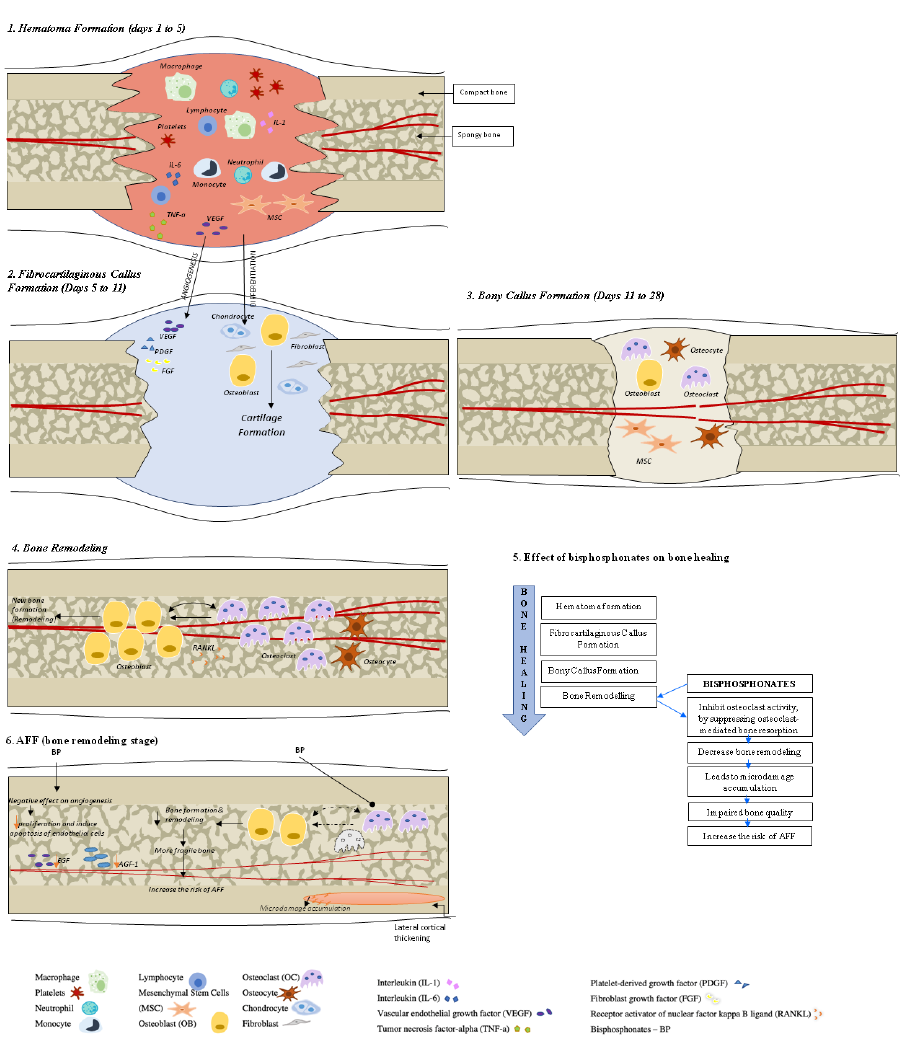
Figure 1. Bone healing in healthy bone and after atypical femoral fracture (AFF). There are four stages that describe the bone healing process: (1) hematoma formation with inflamma- tion, (2) fibrocartilaginous callus formation, (3) bony callus formation, and (4) bone remodeling. During the first stage, a formed hematoma is composed of bone marrow and peripheral and in- tramedullary blood cells. The inflammatory cells (macrophages, neutrophils, lymphocytes, mono- cytes) and degranulating platelets infiltrate the hematoma between the fracture ends, causing acute inflammation and releasing cytokines and growth factors to stimulate the fracture healing process. During the fibrocartilaginous callus formation (stage 2), the soft callus is developed. The soft cal- lus is a semi-rigid tissue able to provide mechanical support to the fracture and act as a template for the bony callus. The cartilaginous matrix is produced until the whole fibrinous/granulation tissue is replaced by cartilage. Angiogenic factors amplify the process of fracture healing vascularization. Further progress of bone regeneration occurs with the replacement of the primary soft cartilaginous callus with a hard bony callus during stage 3 (bony callus formation stage). The last stage represents bone remodeling that is characterized by high levels of bone resorption and formation markers and the migration of osteoblasts and osteoclasts with the hard callus that undergoes repeated remodeling. During this process, the central part of the callus is finally replaced by compact bone, whereas the callus edges are replaced by lamellar bone. See the test for more